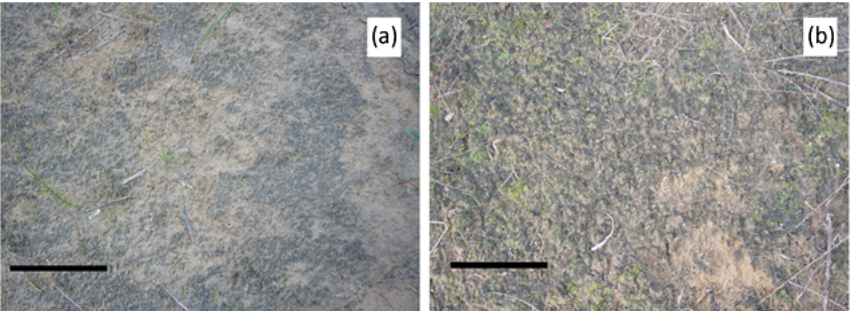
Figure 3. The 13-year-old induced biocrusts in the field in the Qubqi desert (Inner Mongolia), China, by inoculating liquid biomass of M. vaginatus and S. javanicum (10 : 1). (a) “Dark” biocrusts dominated by cyanobacteria (scale bar = 30cm) and (b) biocrusts with perfused moss colonization (scale bar = 10cm). Picture by Federico